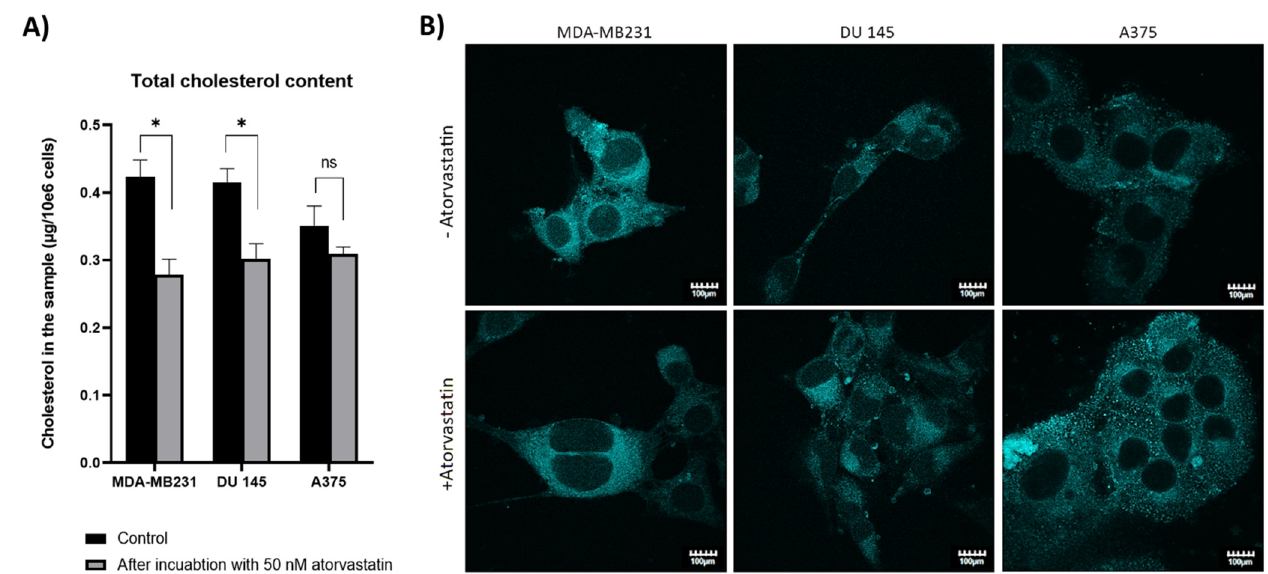
Figure 1. Cholesterol distribution and content studies. ( A ) Changes in the cholesterol content in MDA-MB231, DU 145, and A375 cells incubated for 48 h with 50 nM atorvastatin. Data presented as mean ± SD, * p < 0.05 and ns—not significant difference ( n = 3); ( B ) distribution of cholesterol the MDA-MB231, DU 145, and A375 cells treated with 50 nM atorvastatin for 48 h.